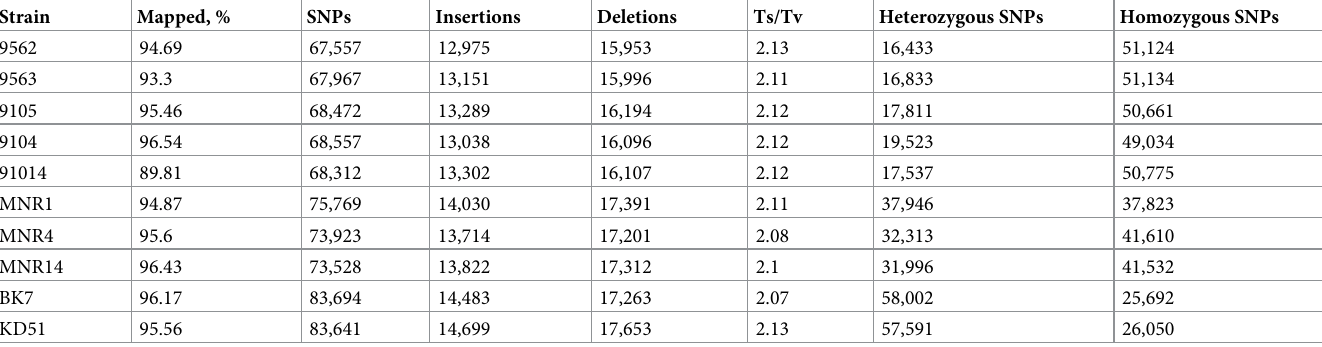
Ts/Tv is transition/transversion ratio.